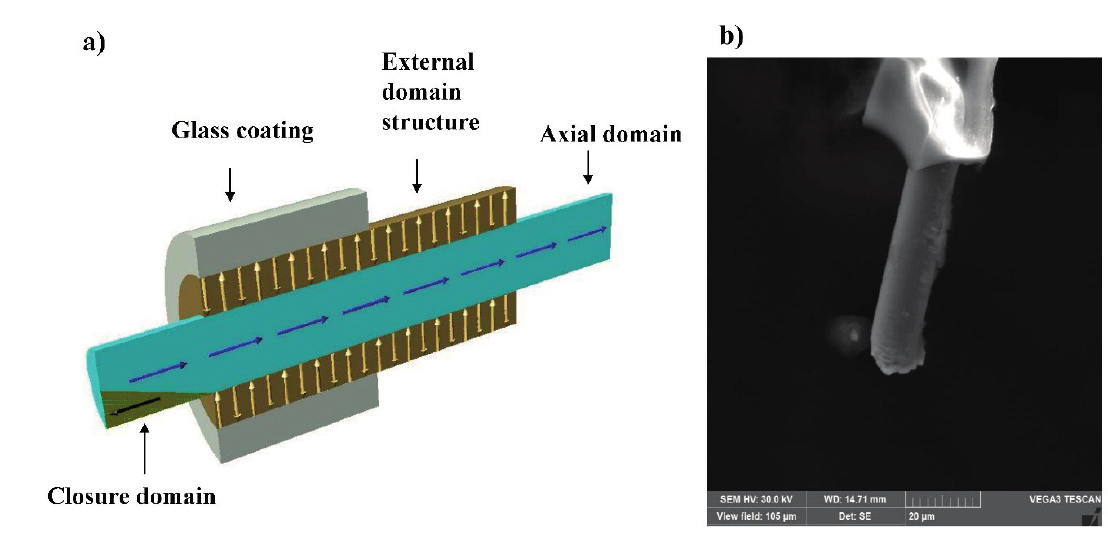
Figure 1. ( a ) Schematic domain structure of positive magnetostriction microwire; ( b ) Micrograph of the glass-coated